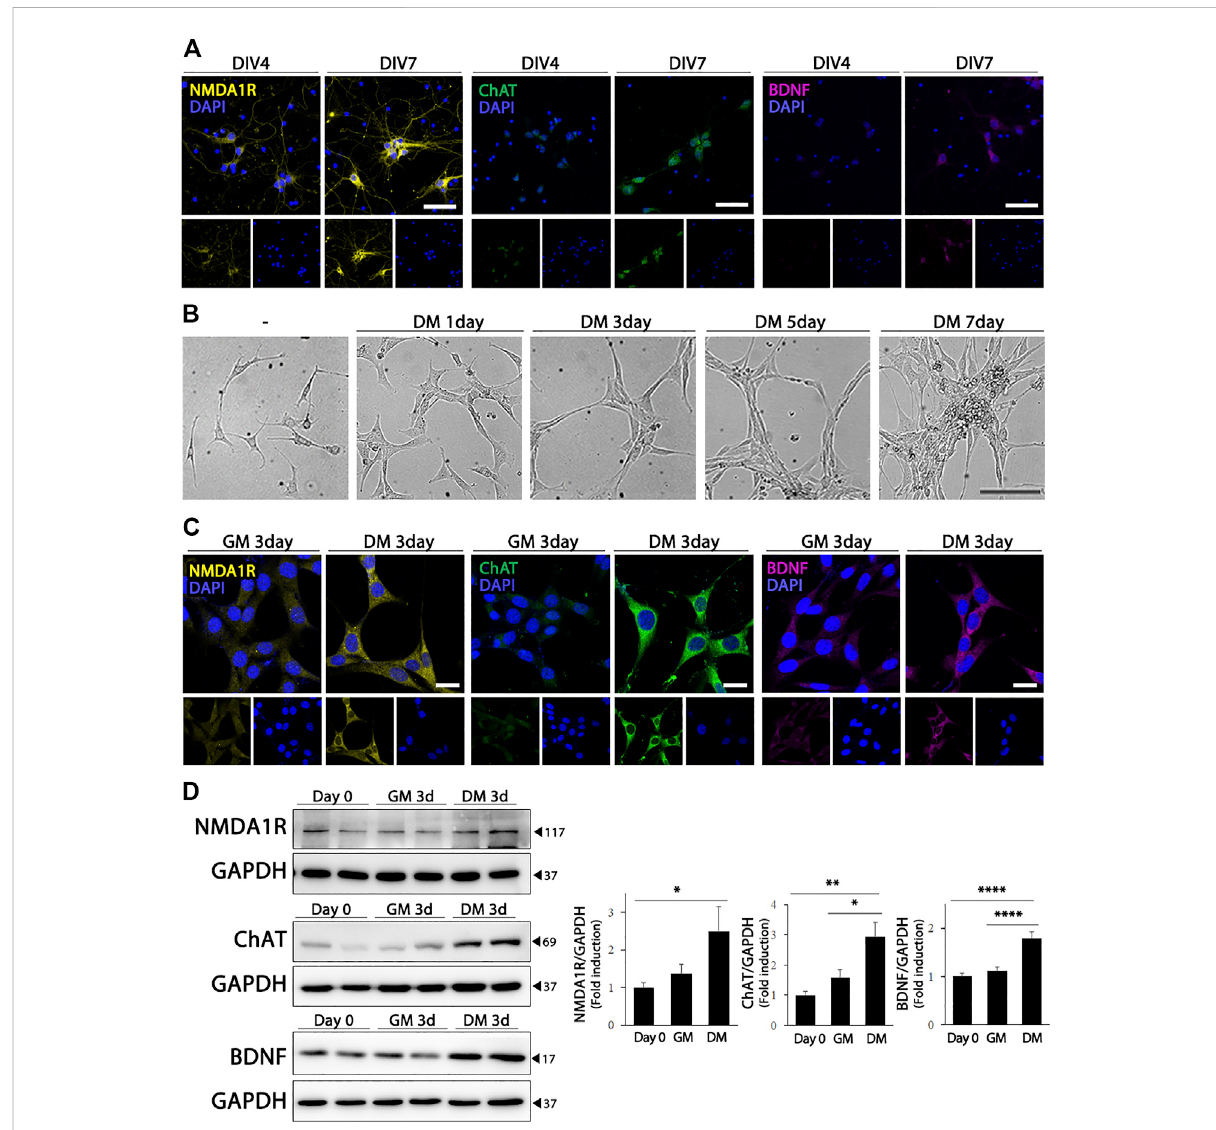
Cholinergic characteristics of differentiated HT22 cells. (A) Immuno fl uorescence staining of NMDA1R (yellow), ChAT (green), and BDNF (magenta) in hippocampal primary culture. DAPI staining (blue) indicates the nucleus. Scale bar = 50 μ m. (B) Phase contrast image of differentiated HT22 cells according to time. Scale bar = 100 μ m. (C,D) NMDA1R, ChAT, and BDNF immuno fl uorescence staining (C) and western blotting (D) of HT22 cells grown in normal growth medium and differentiation medium for 3 d. DAPI staining (blue) indicates the nucleus. Scale bar = 25 μ m, GAPDH was used as loading control. Data are representative of at least three independent experiments and are quanti fi ed using densitometric analysis. Statistical signi fi cance: * p < .05, ** p < .01, and **** p <